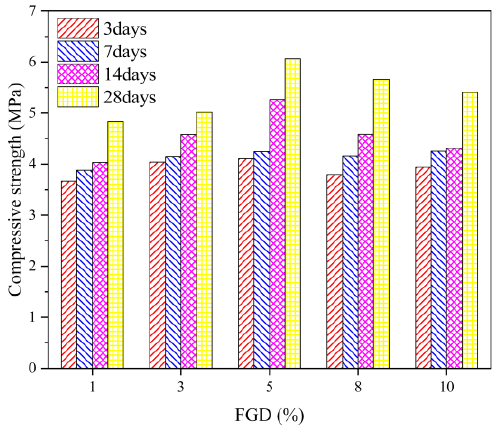
Figure 5. Compressive strength of brick with binary blends.